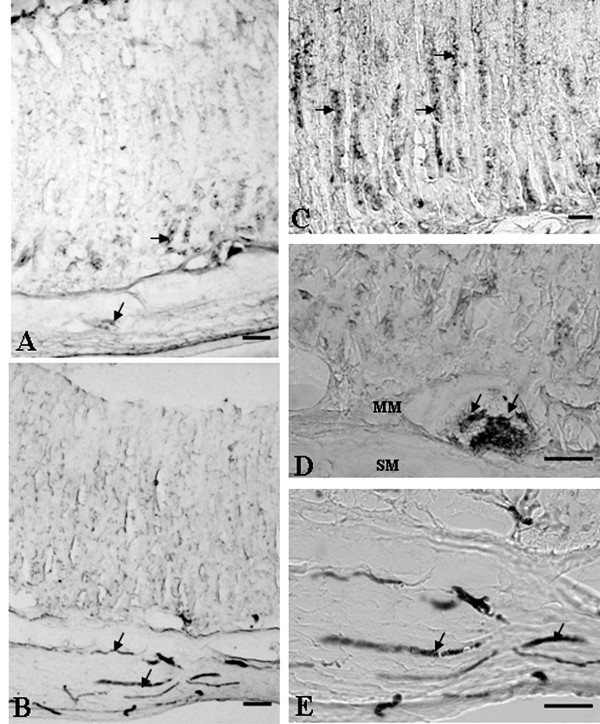
Immunohistochemical localization of taurine in the rat stomach. (A) Light micrography of cross-section showing taurine-positive processes in the antrum. (B) Light micrography of a cross-section showing taurine-immunoreactive processes in the body. (C), (D) A higher magnification of the area in (A) showing taurine-positive processes in the antrum. (E) A higher magnification of the area in (B) showing taurine-positive processes in the body. Taurine-immunoreactive cells mostly occurred in glands of the muscle layers. MM, muscularis mucosa; SM, submucosa. Arrowheads indicate taurine-positive processes. Bar = 50 μm.